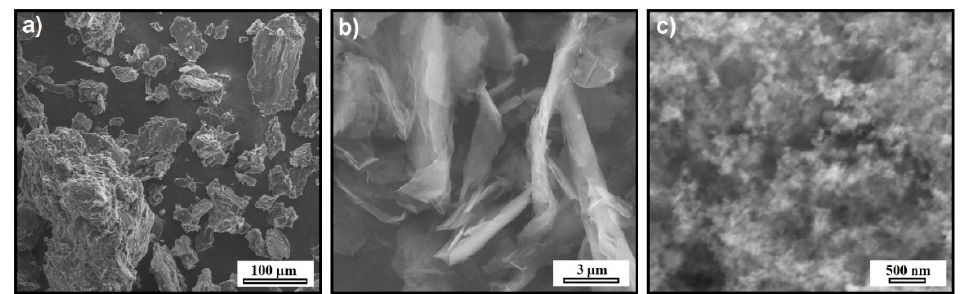
Figure 1. SEM images of the carbon fillers ( a ) synthetic graphite, ( b ) graphene nanoplatelets, and ( c ) carbon black nanoparticles.